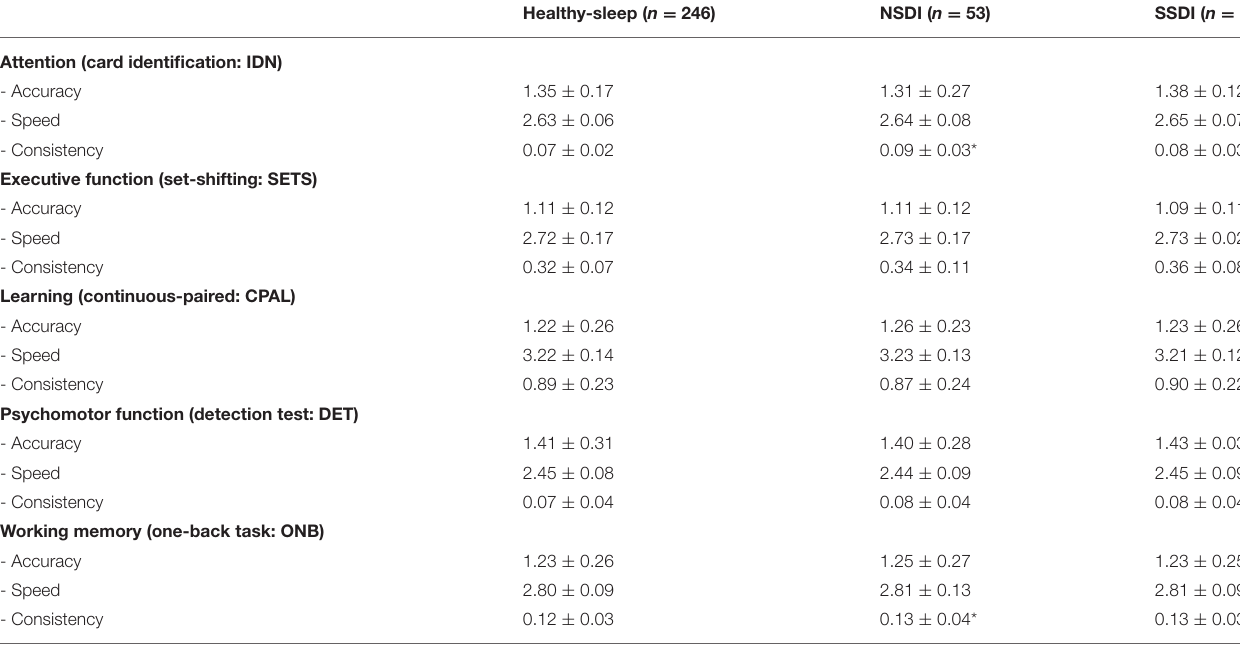
TABLE 2 | Means and standard deviations for lab-assessed cognitive assessments (CogState) for the healthy sleepers, those with NSDI, and SSDI.